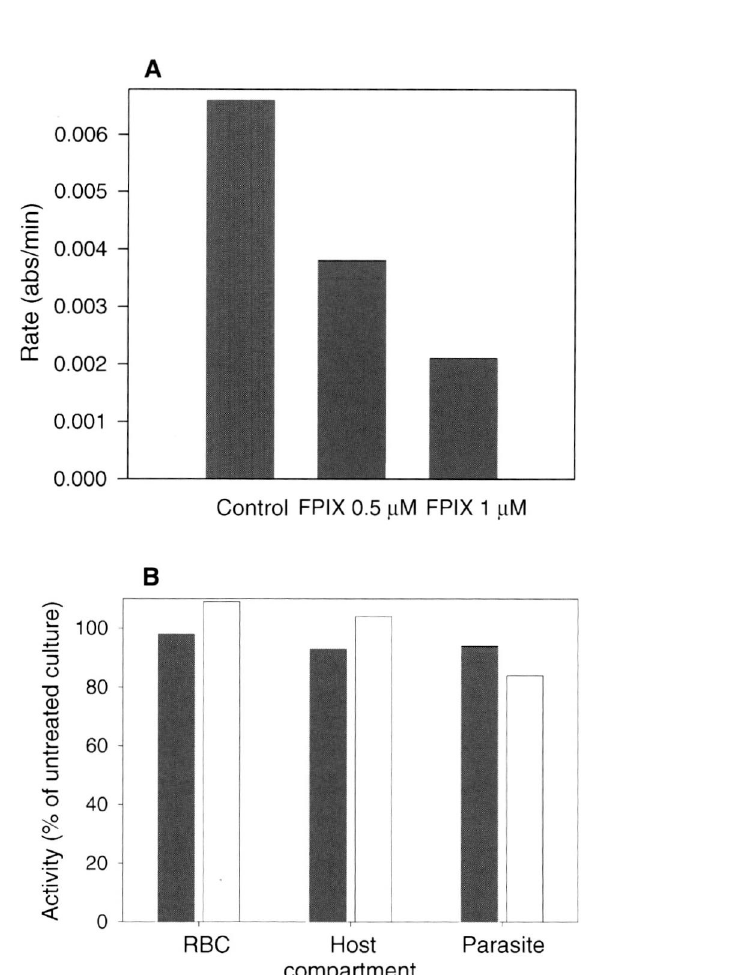
Fig. 6. - Activity of 5'-pyrimidine nucleotidase in normal erythro­ cytes and in the compartments of control and CQ-treated infected cells. A. Enzyme activity was determined in lysates of normal erythrocytes using 50 uM cytidylmonophosphate (al Vmax), in absence or pre­ sence of two concentrations of FPIX. B. Enzyme activity was simi­ larly measured in the lysates of normal erythrocytes (RBC) and in the host cell and parasite compartments of infected cells, after four hotirs of incubation either in absence of drug or in the presence of 10 uM of CQ (filled bars) or 10 uM Q (empty bars). % of activity was calculated with respect to enzyme activity in untreated cells. Shown are representative results of several similar experiments.